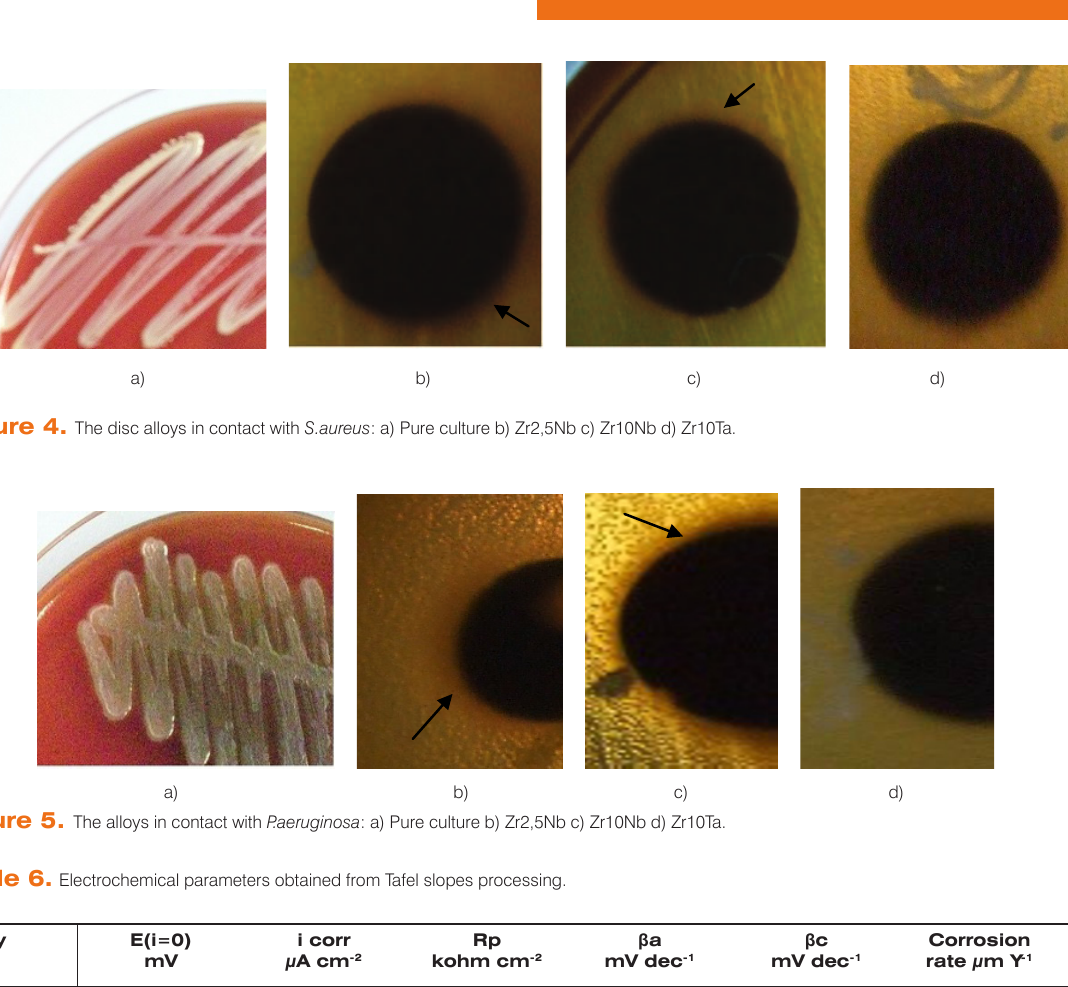
For all the alloys, a single time constant circuit, (O R ) circuit. s bl bl R (Q R ) [23], was proposed to fit the EIS data s bl bl (Fig. 3b). The parameters R and R represent the s bl electrolyte resistance (R ) and the resistance of passive s film (R ). Q is a constant phase element (CPE), bl bl representing the non-ideal capacitive behavior of the film. The physical model for the equivalent circuit indicates the presence of a single layer on the metallic surfaces. This film seems to possess both resistance and capacitance. The electrochemical parameters of the equivalent circuits obtained after fitting of the EIS data are presented in Table 7 .